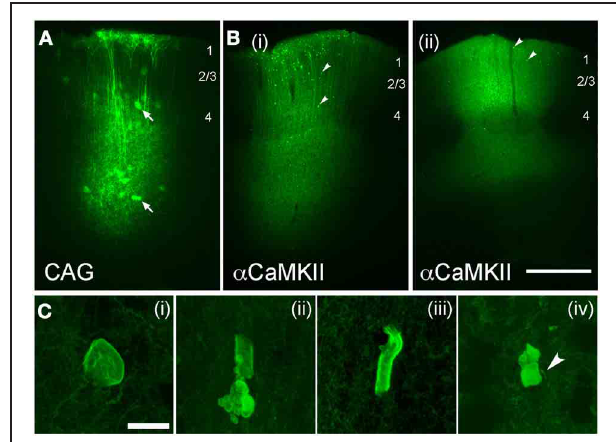
FIGURE 7 | Axonal swellings after viral-mediated expression of ChR2. (A,B) , Low-power images of EYFP expression following long-term expression of AAV2.5-CAG-ChR2(H134R)-EYFP-WPRE ( A ; 80 days post-injection) and AAV2.5- α CaMKII-ChR2(H134R)-EYFP-WPRE [ B(i) and B(ii) , 80 and 100 days post-injection, respectively]. Arrows in (A) , infected astrocytes. Arrowheads in (B) , ChR2 puncta. Scale bar for (A,B) is 500 μ m. (C) Examples of axonal malformations in AAV2.5- α CaMKII cases. Arrowhead in C(iv) , entering/exiting axon. Scale bar, 10 μ m.